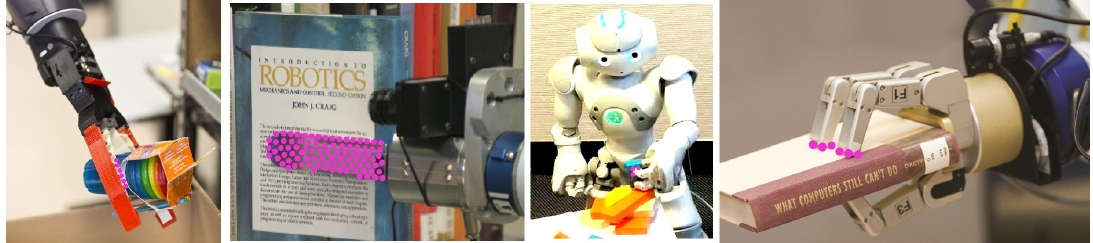
Figure 3. Contact points resulting from robotic grippers grasping an